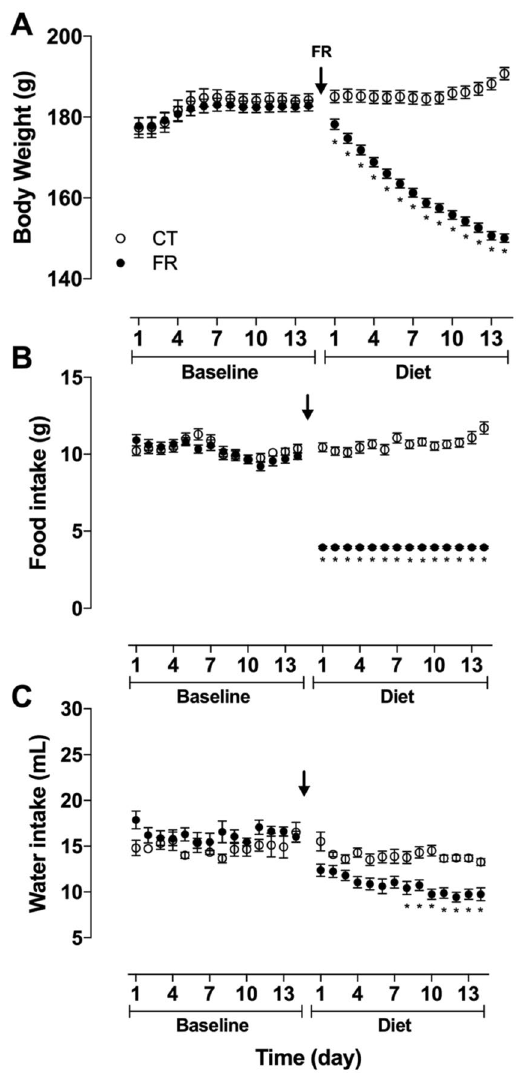
food (CT, n = 34; FR, n = 41) ( B ) and water (CT = 10; FR = 16) ( C ) intake in female rats before (baseline) and after maintenance on a CT (open circle) or FR (closed circle) diet. * p < 0.05 vs. CT, by two-way ANOVA and Bonferroni post-hoc test (time; diet). Values are expressed as the mean ±